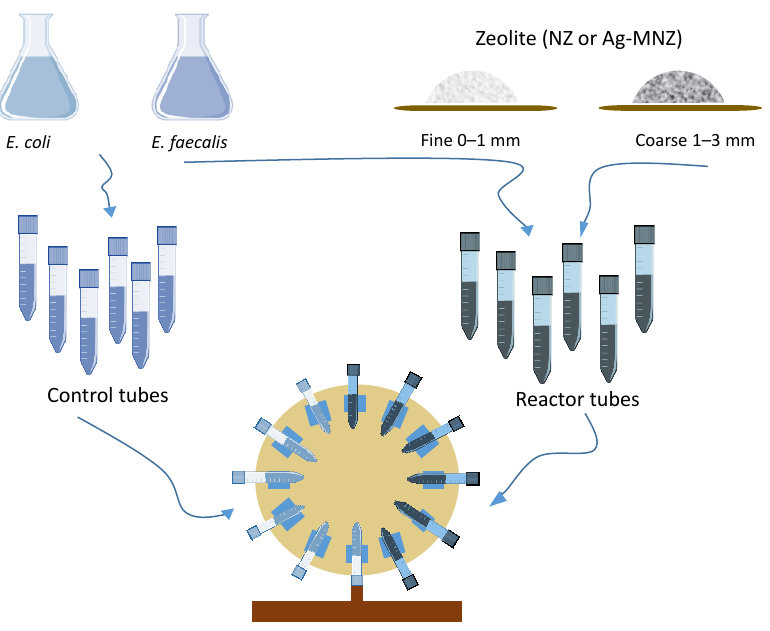
Figure 2. Graphical representation of the dynamic batch experimental procedure. The control tubes were filled with bacteria suspension and the reactor tubes were filled with bacteria suspension as well as natural zeolite or Ag-modified natural zeolite. All tubes were attached to a tube rotator at 12 rpm and 22 °C.